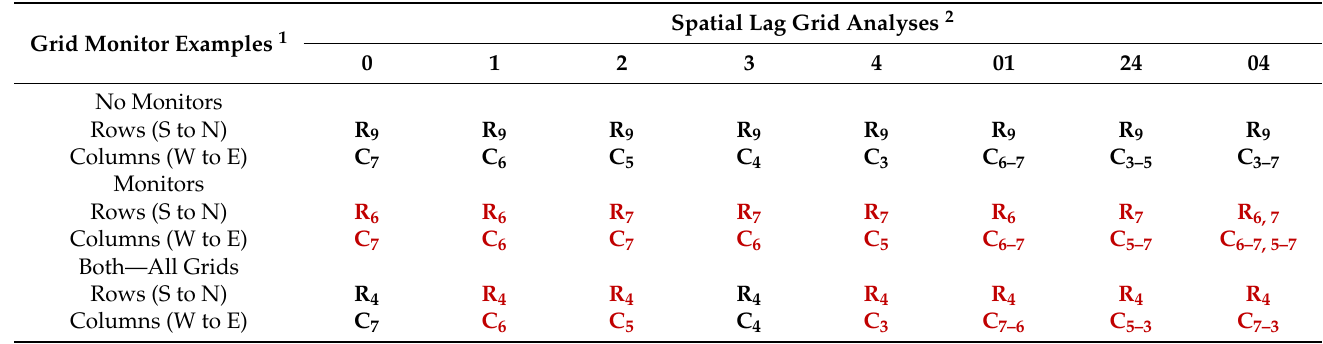
Table 3. Three examples of bidirectional spatial lag grid case-crossover analyses, by ambient PM 2.5 air monitor status: no monitors, monitors, and both monitor grid conditions